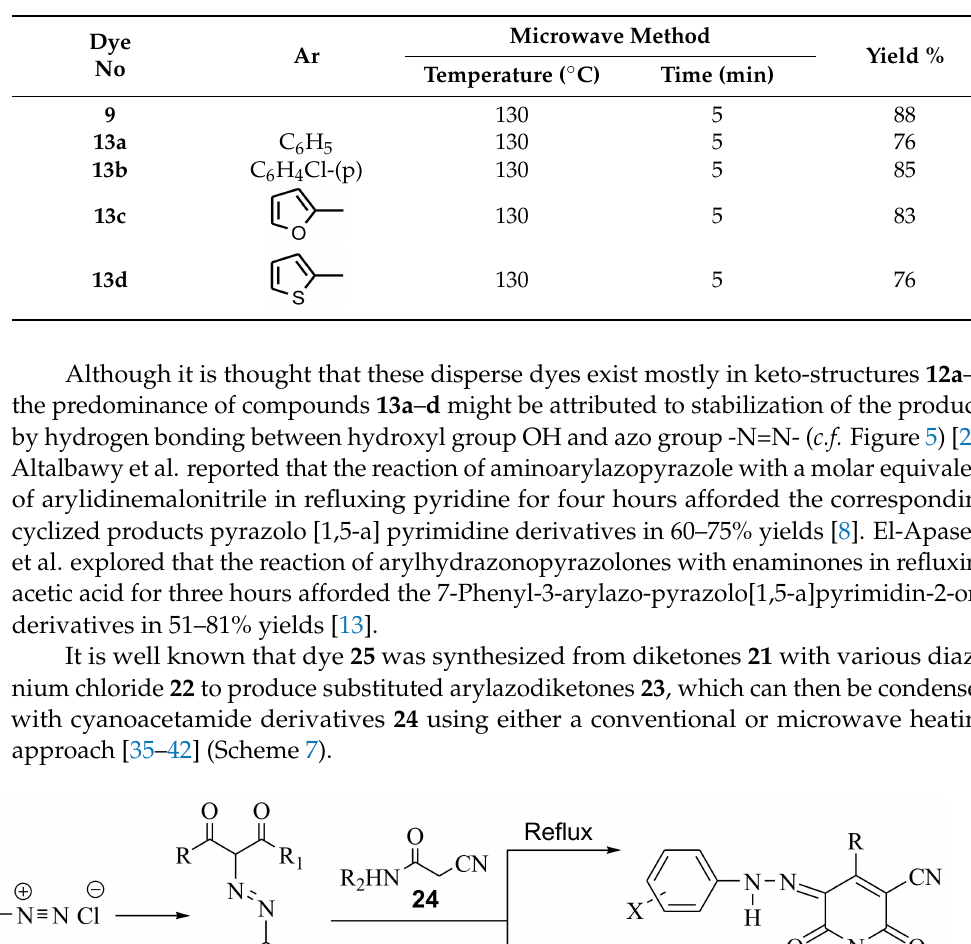
Table 2. One-pot synthesis of compounds 9 and 13a – d